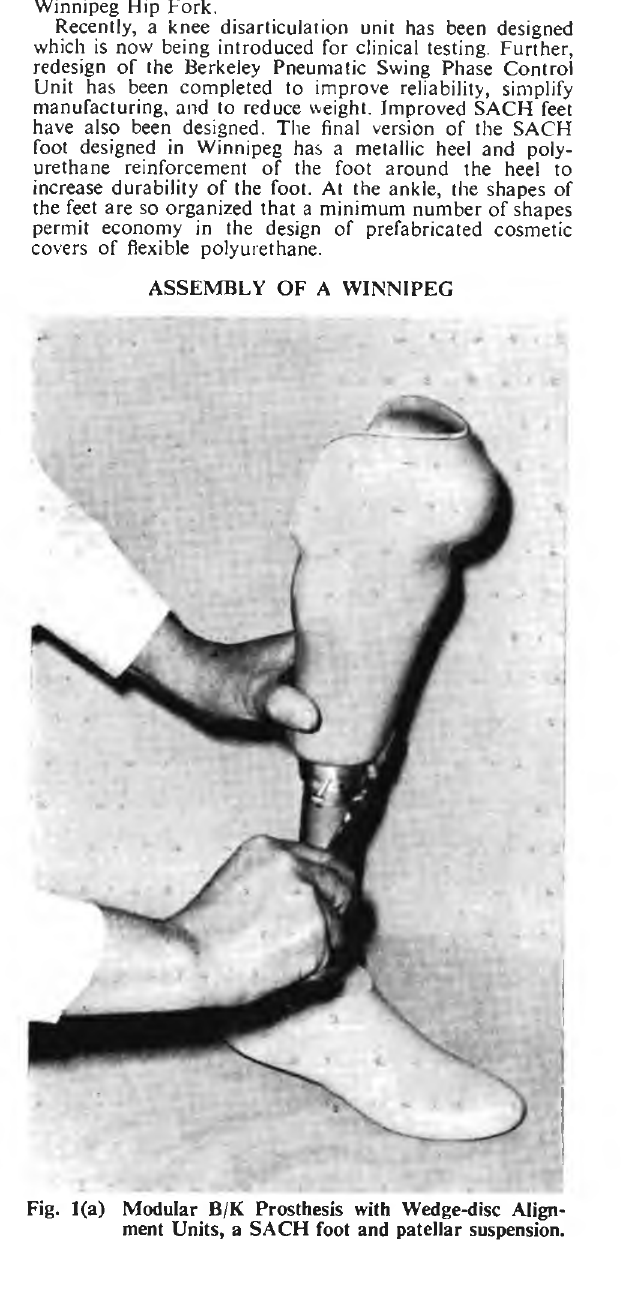
Fig. 1(a) Modular B/K Prosthesis with Wedge-disc Align­ ment Units, a SACH foot and patellar